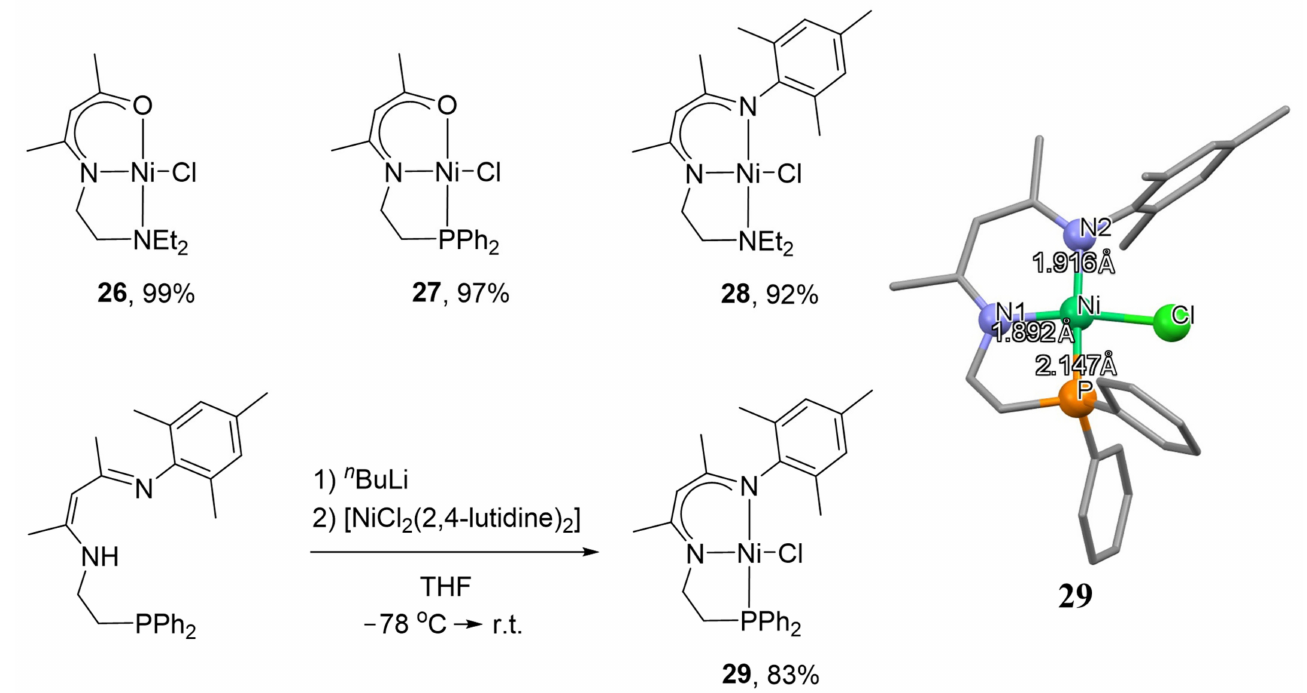
Scheme 13. Structure of unsymmetrical pincer nickel complexes 26 – 28 and synthesis of unsymmetrical NNP pincer nickel complex 29